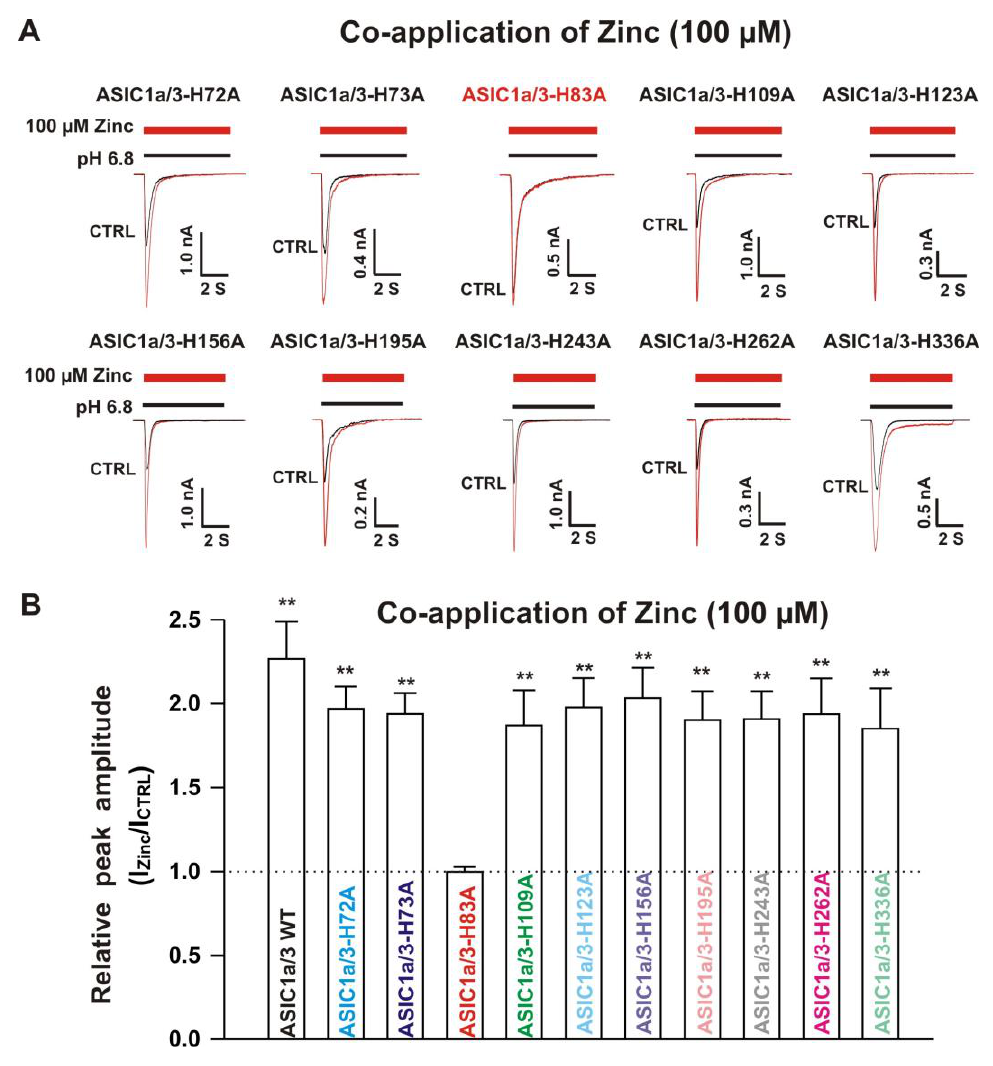
Figure 12. Effects by co-application of zinc on currents from ASIC1a WT co-expressed with ASIC3 histidine mutants on CHO cells. ( A ) Representative traces show that co-application of zinc at a concentration of 100 µM potentiated the peak amplitude of the currents recorded from heteromeric ASIC1a/3-H72A, ASIC1a/3-H73A, ASIC1a/3-H109A, ASIC1a/3-H123A, ASIC1a/3-H156A, ASIC1a/3-H195A, ASIC1a/3-H243A, ASIC1a/3-H262A, and ASIC1a/3-H336A, but not ASIC1a/3-H83A; ( B ) Statistical bar graphs show relative peak amplitude of the currents from ASIC1a/3 WTs and its histidine mutant co-expressed with ASIC3 WT as mentioned above by co-application of 100 µM zinc ( n = 7 to 15). Co-application of 100 µM zinc did not affect the current without zinc application on ASIC1a/3-H83A ( p > 0.05, t-test). There was no significant difference for zinc potentiation among ASIC1a/3 WTs with ASIC1a WT co-expressed with ASIC3 histidine mutants except ASIC1a/3-H83A ( p > 0.05, ANOVA). For ASIC3 mutation, histidine residues in the extracellular domain of ASIC3 were replaced with alanine. Whole-cell patch-clap recording was performed, and currents recorded from heteromeric ASIC1a/3 WTs and ASIC1a WT with ASIC3 histidine mutants were triggered by a drop in pH from 7.4 to 6.8. Data are presented as mean ± SEM. CTRL, control; I CTRL , ASIC current without any treatment; I Zinc , ASIC current by zinc treatment. ** p < 0.01 (t-test).